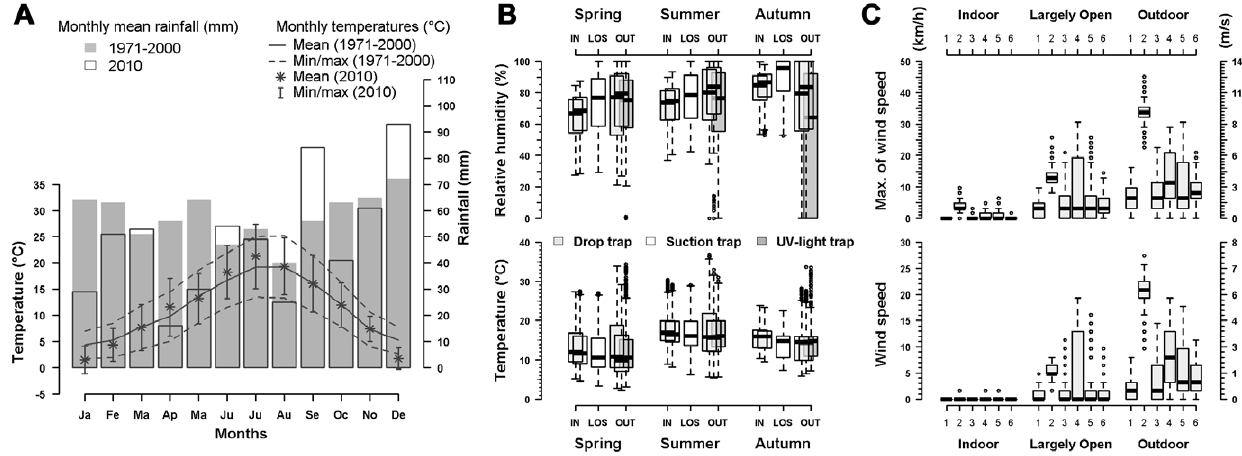
Figure 3. Number of Culicoides collected outdoor in host-baited traps compared to temperature and relative humidity recorded by data loggers. Lines are the distribution histogram of meteorological parameters recorded during the collections.